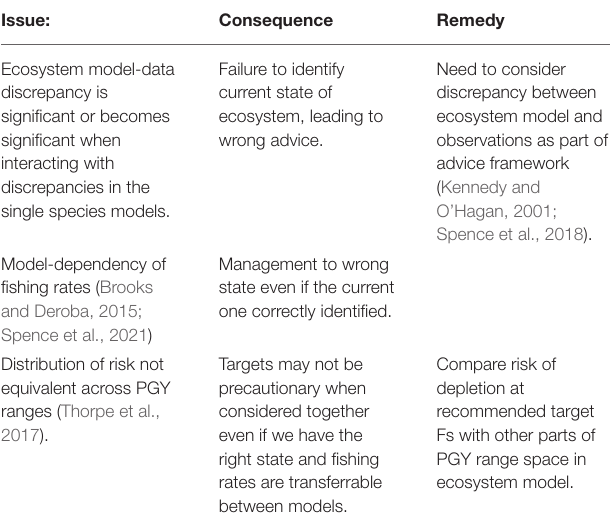
TABLE 1 | Incorporating ecosystem considerations into the advisory process.